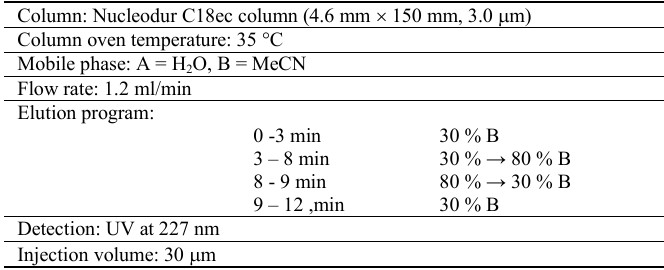
Table 1: Optimized conditions of the RP-HPLC method for PTX determination